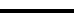
Figure 8: Tracey Clement, Post-Premonitionism 2 , Metropolis Experiment, Drowned World maps installed at SCA Galleries,